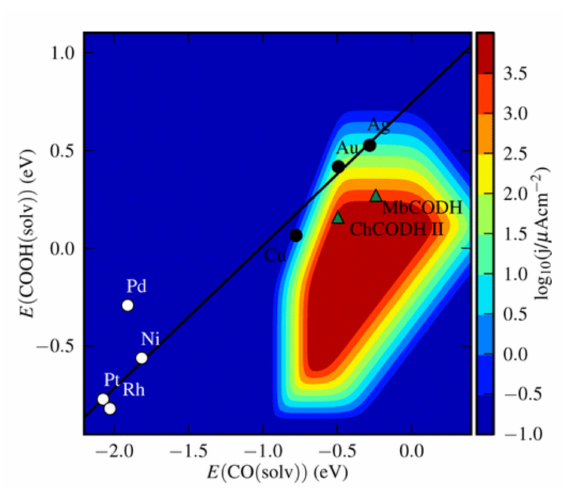
Figure 11. Kinetic volcano plot for the CO evolution at a 0.35 V overpotential on different transition metals. It shows that on transition metals, the weaker the CO adsorption on the catalyst, i.e., the higher the CO rate production, the weaker the COOH* adsorption on the catalyst itself, which means that higher overpotential is needed to guarantee the starting of the CO evolution reaction. Enzymes such as MbCODH and ChCODH II do not obey this linear relationship, showing superior CO 2 RR activity at low overpotentials. Reprinted with permission from Ref. [19]. Copyright 2022 American Chemical